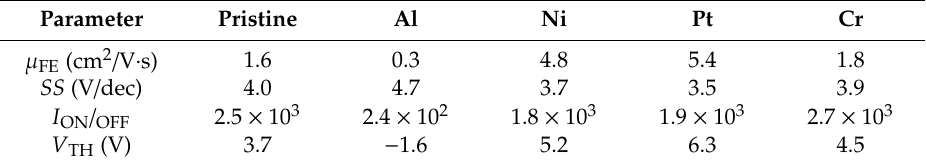
Table 1. Electrical parameters extracted from the SnO TFTs with di ff erent metal capping layers.